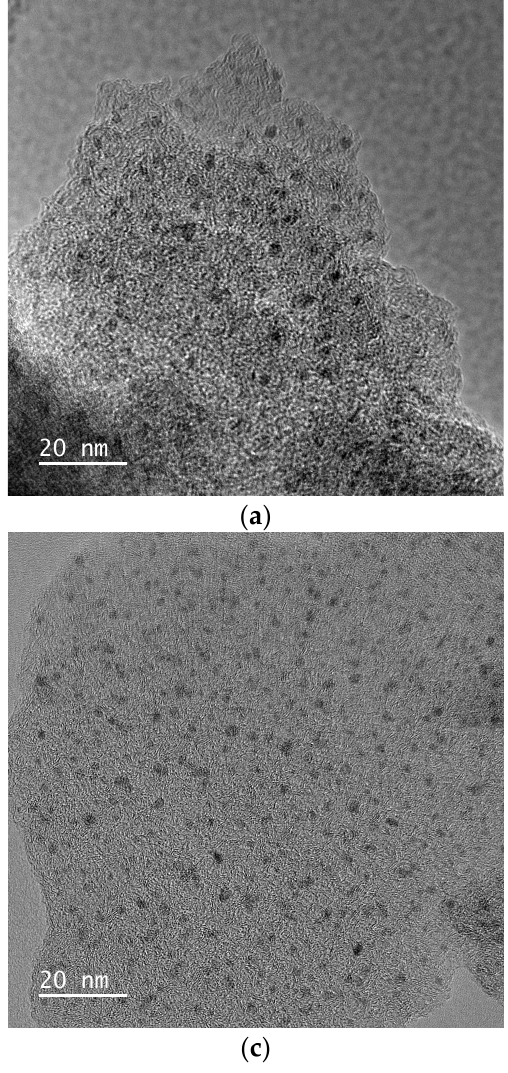
Figure 8. TEM images of supported palladium catalysts obtained with the functionalized MC supports: ( a ) Pd/MC-ox200; ( b ) Pd/MC-ox400; ( c ) Pd/MC-ox600; ( d ) Pd/MC-ox800. Table 4. Characteristics of the Pd/MC-ox catalysts.